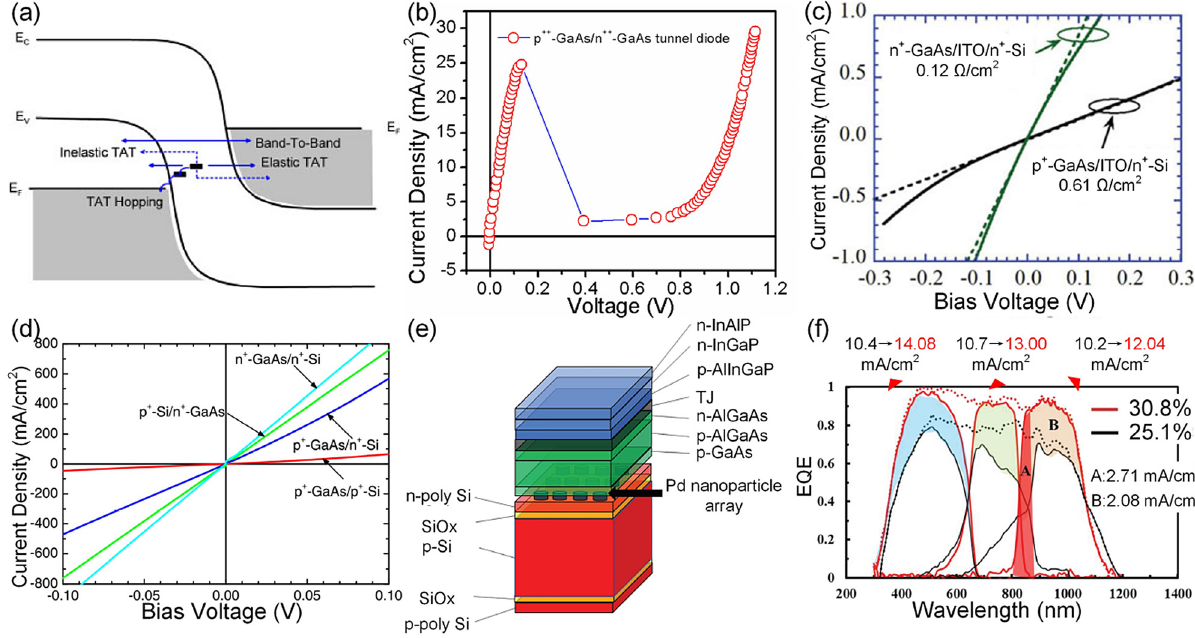
Figure 8: (a) Schematic view of the different tunneling mechanisms in a tunnel diode, (TAT = trap assisted tunneling) [144]. Copyright 2008, JohnWileyandSons.(b)MeasuredIVcurveof p ++ -GaAs/ n ++ -GaAstunneljunction[144].Copyright2008,JohnWileyandSons.(c)Measured I – V curve of a n + -GaAs/ITO/ n + -Si and p + -GaAs/ITO/ n + -Si 2T tandem devices with a postanneling (400 ° C for 5 min) [137]. (d) I – V characteristics of p + -Si/ n + -GaAs, p + -GaAs/ p + -Si, n + -GaAs/ n + -Siand p + -GaAs/ n + -Situnneljunctionsmeasuredat roomtemperature[137].(e)Schematicdiagram of a 2T InGaP/GaAs/Si TSC with Pd nanoparticle arrays as bonding mediators [46]. Copyright 2019, John Wiley and Sons. (f) EQE spectra of InGaP/GaAs/Si and InGaP/AlGaAs/Si TSCs with Pd nanoparticle arrays as bonding mediators [46]. Copyright 2019, John Wiley and